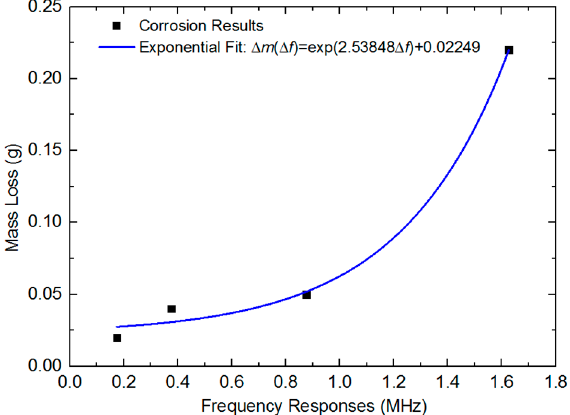
Figure 11. The mass loss of corrosion degree in four corrosion sections trendline estimates from frequency responses.